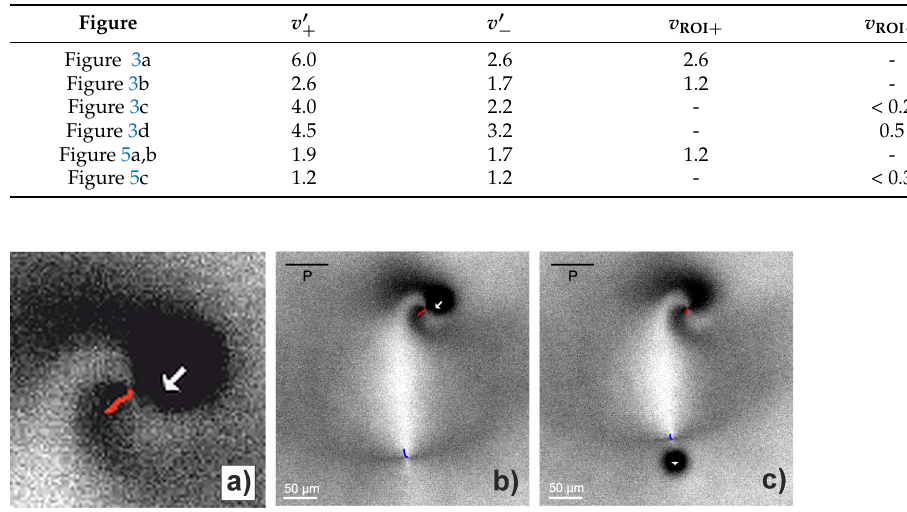
Figure 5. Flow field in a strongly mismatched pair of defects (mismatch angle approximately 180 ◦ ). Because of the mismatch of the orientations, the defects do not approach each other along the straight interconnection line. The images show the pair with ROI near the + 1 defect ( b ) and the − 1 defect ( c ). ( a ) A magnification of the + 1 defect and ROI from image ( b